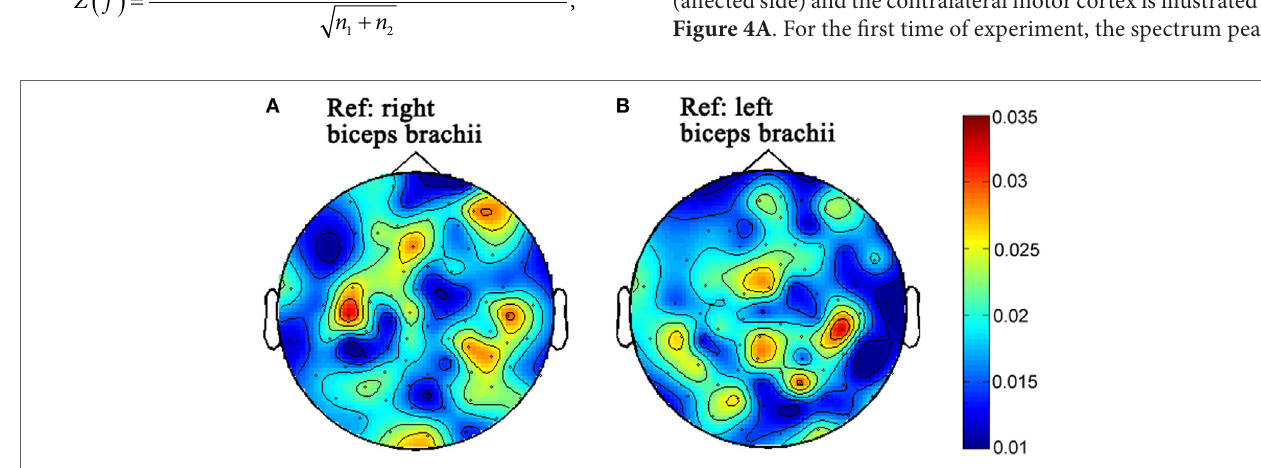
FIgURe 2 | The topographies of beta-band (15–30 Hz) corticomuscular coherence with the peripheral reference of right biceps brachii (a) and left biceps brachii (B) , respectively for the first time of